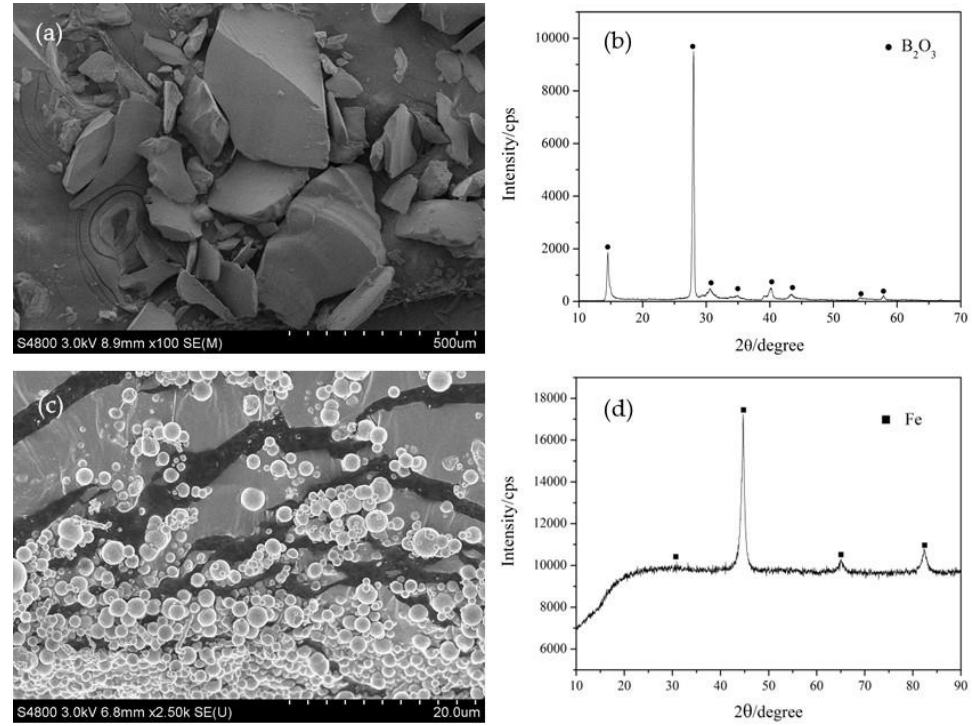
Figure 1. SEM images and XRD patterns of raw materials. ( a ) SEM image of B 2 O 3 , ( b ) XRD pattern of B 2 O 3 , ( c ) SEM image of Fe and ( d ) XRD pattern of Fe.